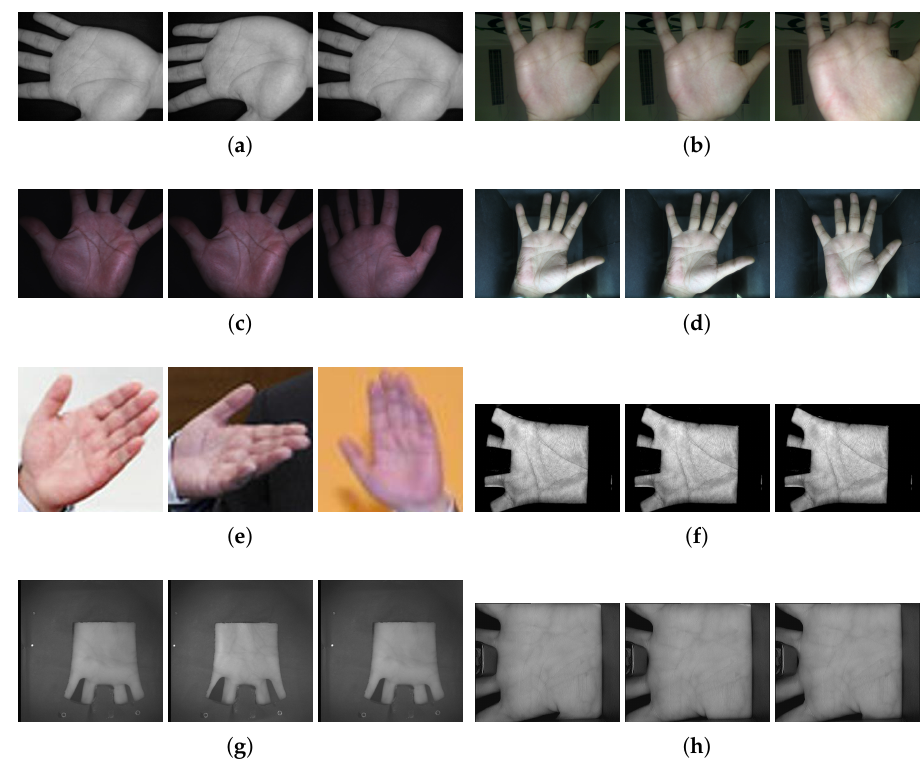
Figure 4. Different types of original palmprint images, where the samples from ( a – h ) are